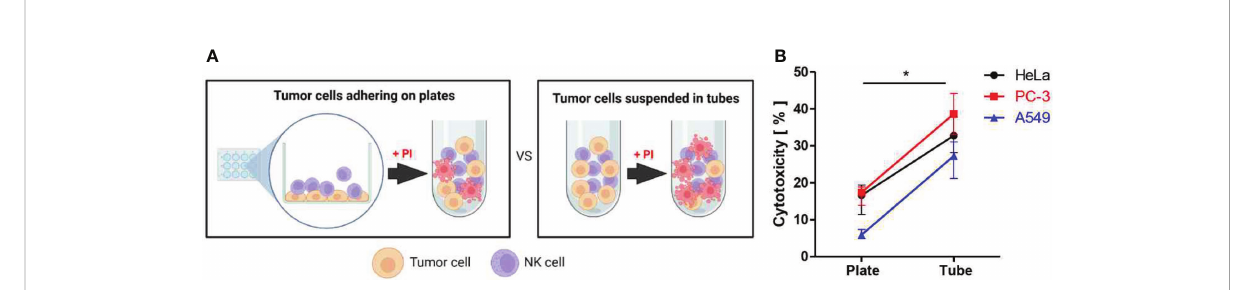
FIGURE 1 Assessment of NK cell cytotoxicity against solid tumor cells adhering on plates vs. suspended in tubes. (A) Schematic illustration of experimental settings. (B) Effects of substrate adhesion of various solid tumor cells on NK cell mediated cytotoxicity. Mann-Whitney test was used, * < 0.05. Created with